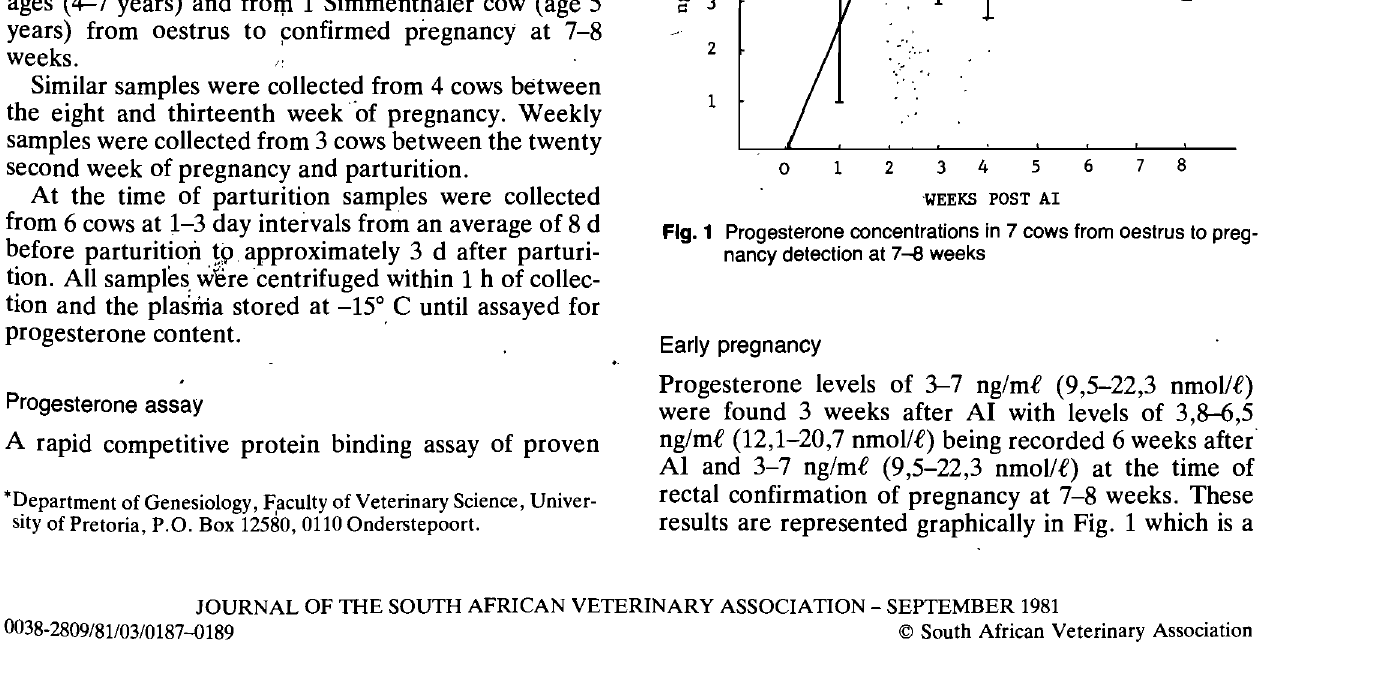
Fig. 1 Progesterone concentrations in 7 cows from oestrus to preg nancy detection at 7--8 weeks